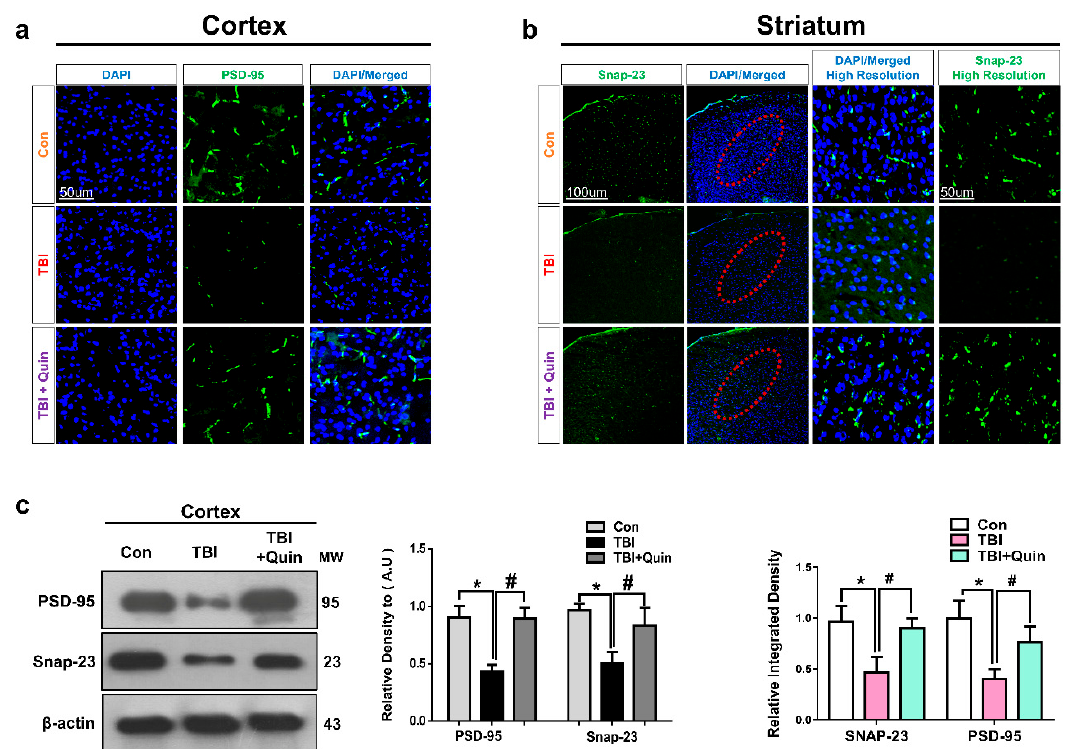
Figure 6. Quinpirole regulates synaptic protein loss after brain injury. ( a , b ) Confocal microscopy images for PSD-95 and SNAP-23 expression in the ipsilateral cortex and striatum of an injured mouse brain (green, FITC; blue, DAPI), with respective bar graphs, the red dotted lines showing the striatum region, (magnification × 10, n = 6). The protein band levels were quantified using the SigmaGel software. ( c ) Images showing results of Western blot and histogram analysis for PSD-95 and sanp-23 in ipsilateral cortex of injured mouse brain. The β -actin was used as a loading control ( n = 5). Data were obtained following three independent experiments. The ImageJ software was used for quantitative analysis of the confocal microscopy images. Values are expressed as mean ± SEM. We performed the one-way ANOVA test followed by post-hoc analysis. A p value < 0.05 was considered statistically significant. * significantly different between the control and brain injury groups, # significantly different between the brain injury and quinpirole-treated groups. ANOVA: analysis of variance, PSD-95: post-synaptic density protein 95, SEM: standard error of mean, SNAP-23: synaptosomal-associated protein 23, TBI: traumatic brain injury.